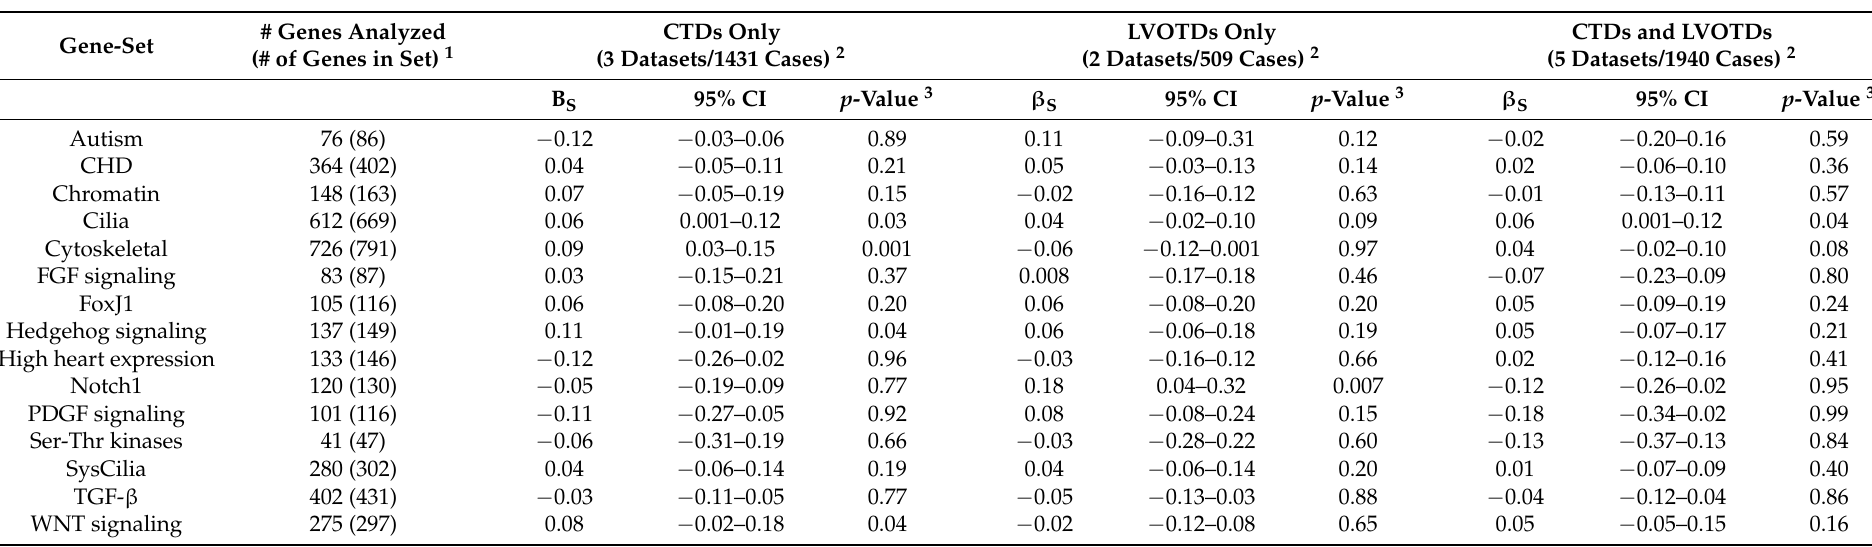
Table 2. Summary of gene-set analyses for CTDs only ( N = 1431 cases), LVOTDs only ( N = 509 cases), and CTDs and LVOTDs ( N = 1940)